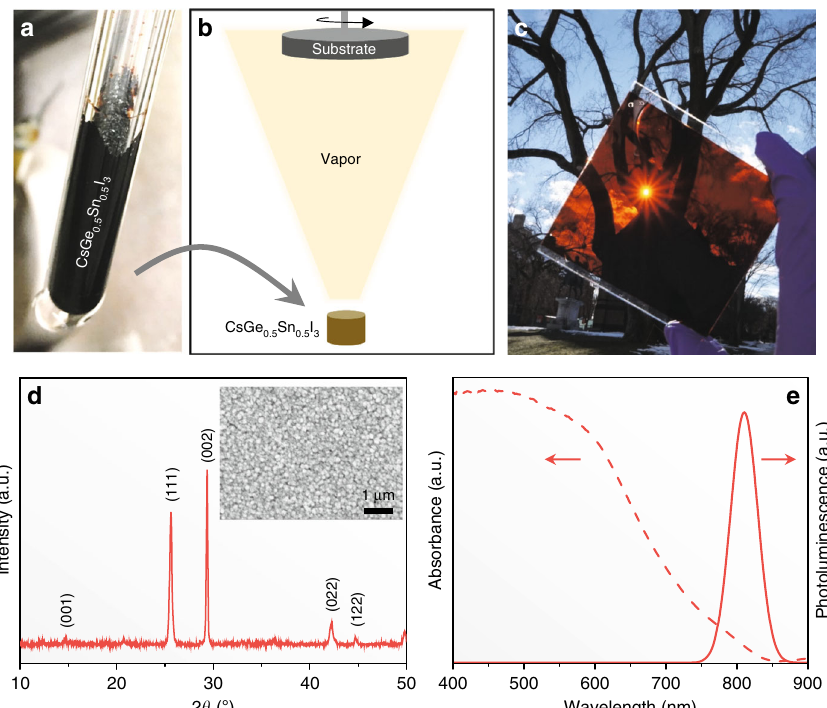
Fig. 1 Film synthesis and characterization. a Photograph of as-synthesized CsSn 0.5 Ge 0.5 I 3 perovskite solid using the melt-crystallization method. b Schematic illustration of the single-source evaporation method for the deposition of ultrasmooth CsSn 0.5 Ge 0.5 I 3 perovskite thin fi lm. c Photograph of an as-synthesized large-area CsSn 0.5 Ge 0.5 I 3 perovskite thin fi lm on a glass substrate showing dark reddish color. d Indexed XRD pattern of the fresh CsSn 0.5 Ge 0.5 I 3 perovskite thin fi lm (inset: top-view SEM image of the microstructure). e Absorption and steady-state PL spectra of a fresh CsSn 0.5 Ge 0.5 I 3 perovskite thin fi